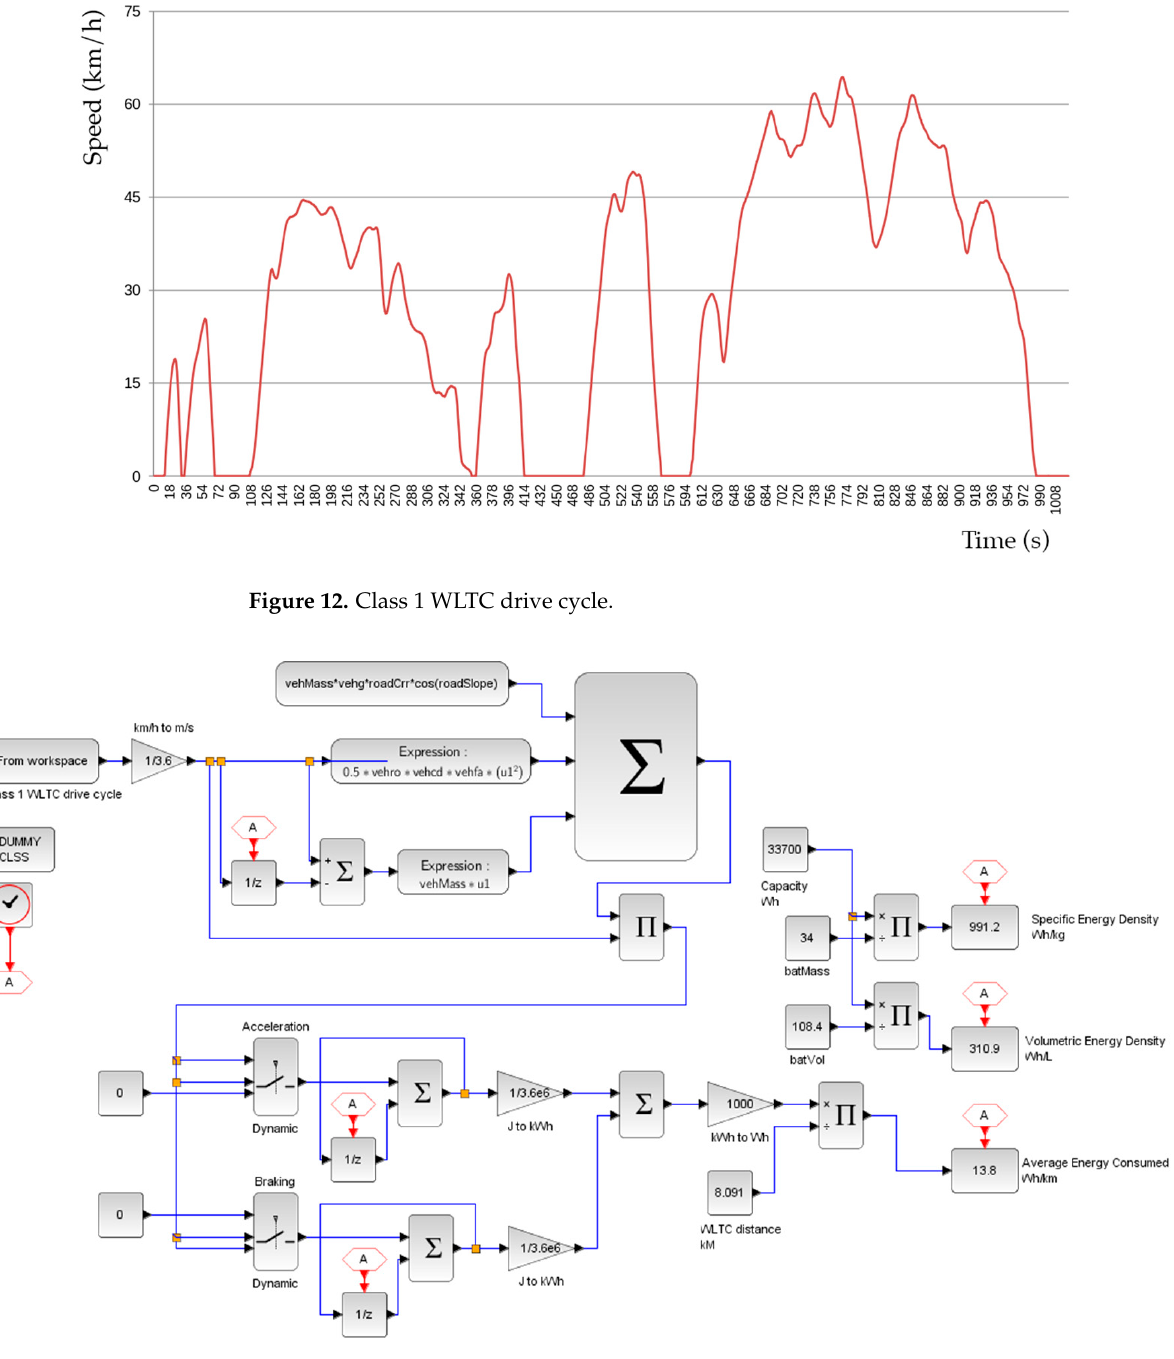
Table 2. Vehicle and energy system specifications.